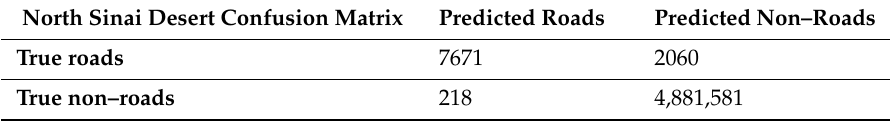
Table 4. Confusion matrix for true and detected roads, with only the VV backscatter as input, calculated for the same area as in Figures 7–9.